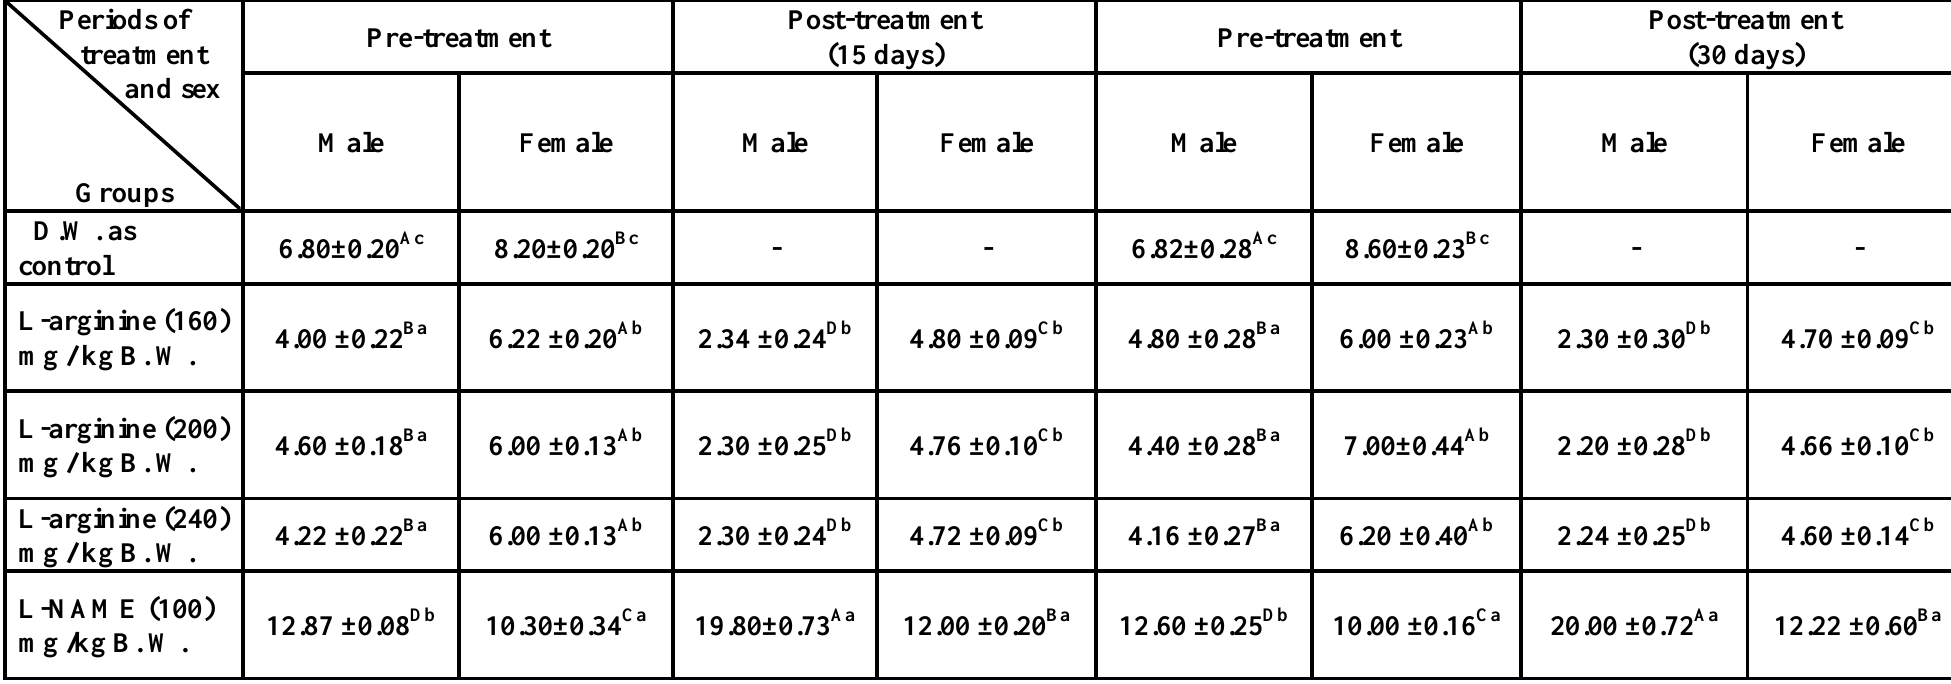
Table (2): The effect of L-arginine treated orally and L-NAME intraperitoneally daily on hot plate analgesic test the reactive time to thermal stimuli (second) in male and female mice.